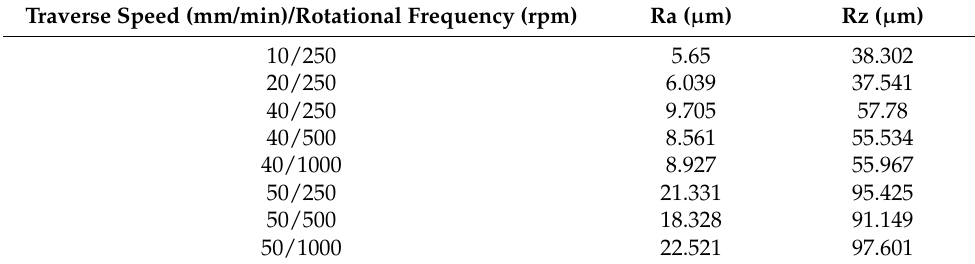
Table 11. Roughness of the specimen for a certain traverse speed and the rotational frequency. Traverse Speed (mm/min)/Rotational Frequency (rpm)